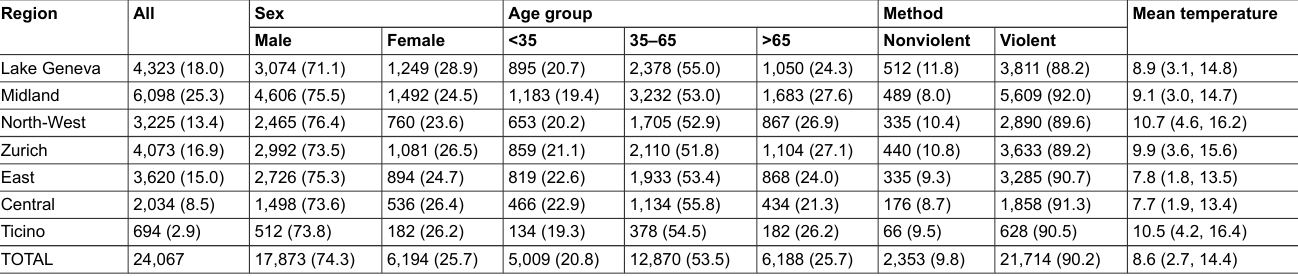
Table 1: Summary statistics of suicides and mean daily temperature in the seven major regions of Switzerland. Region